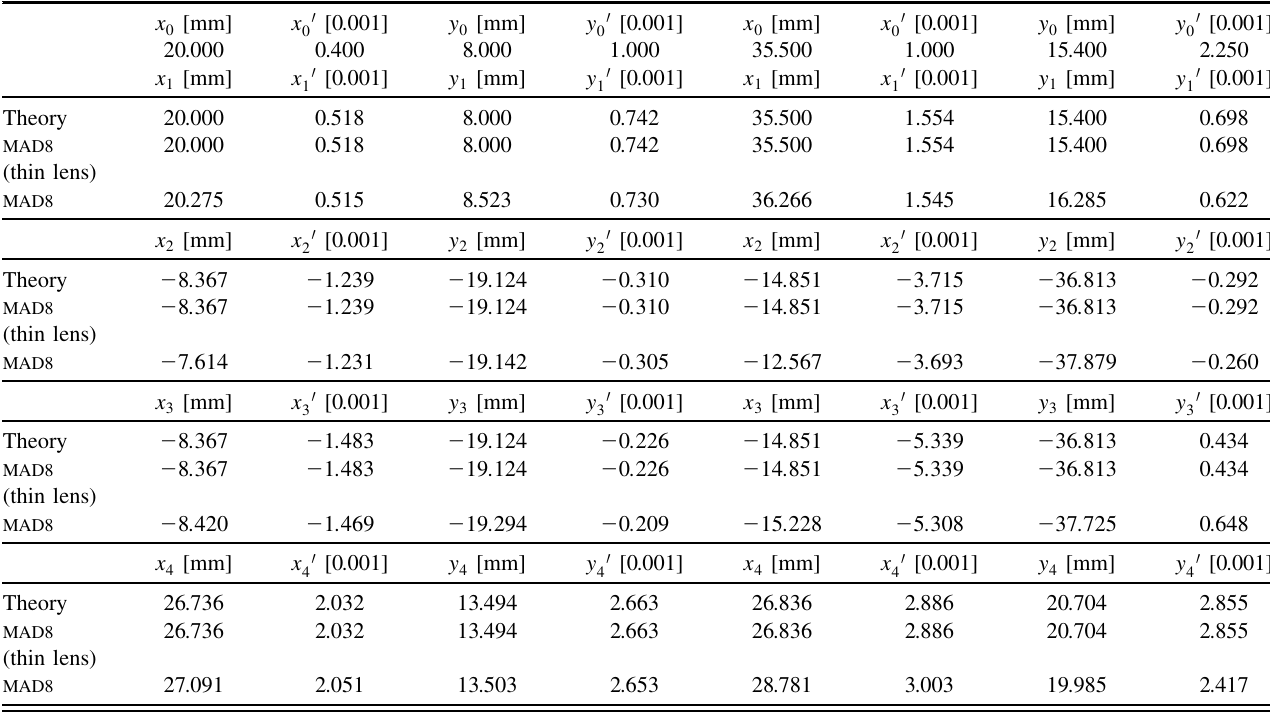
TABLE III. The particle coordinates comparison of theory and simulation with MAD8